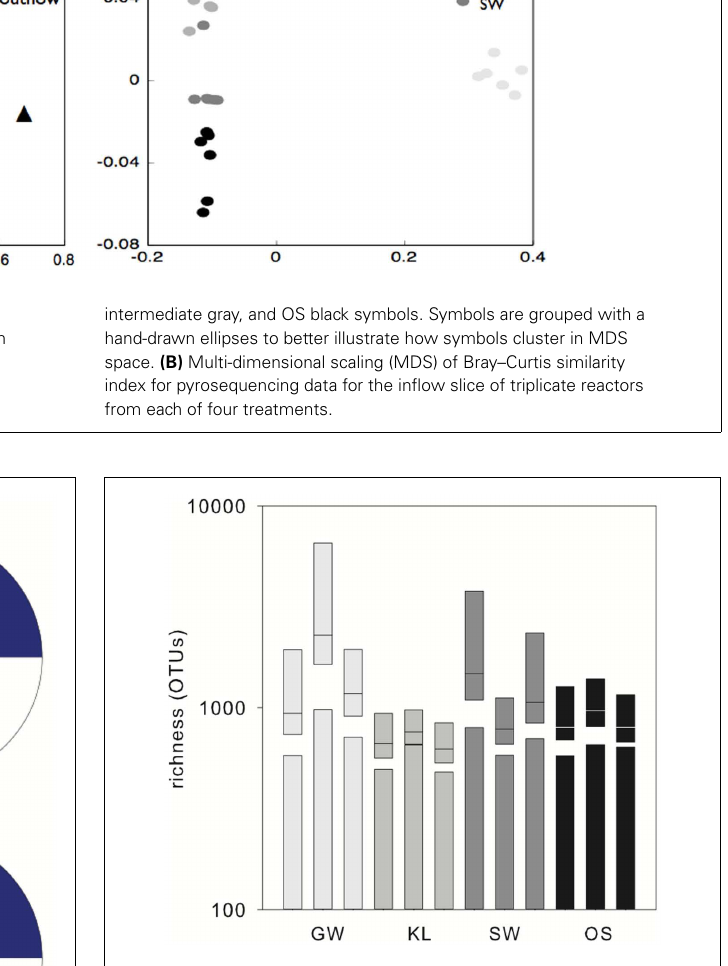
FIGURE 4 | OTU richness in the inflow sections of the triplicate bioreactors. Bars represent the Chao estimator of richness, boxplots represent the richness estimates (medians with 95% confidence interval), calculated by fitting Sichel distribution curves to the abundance distributions obtained from the pyrosequencing